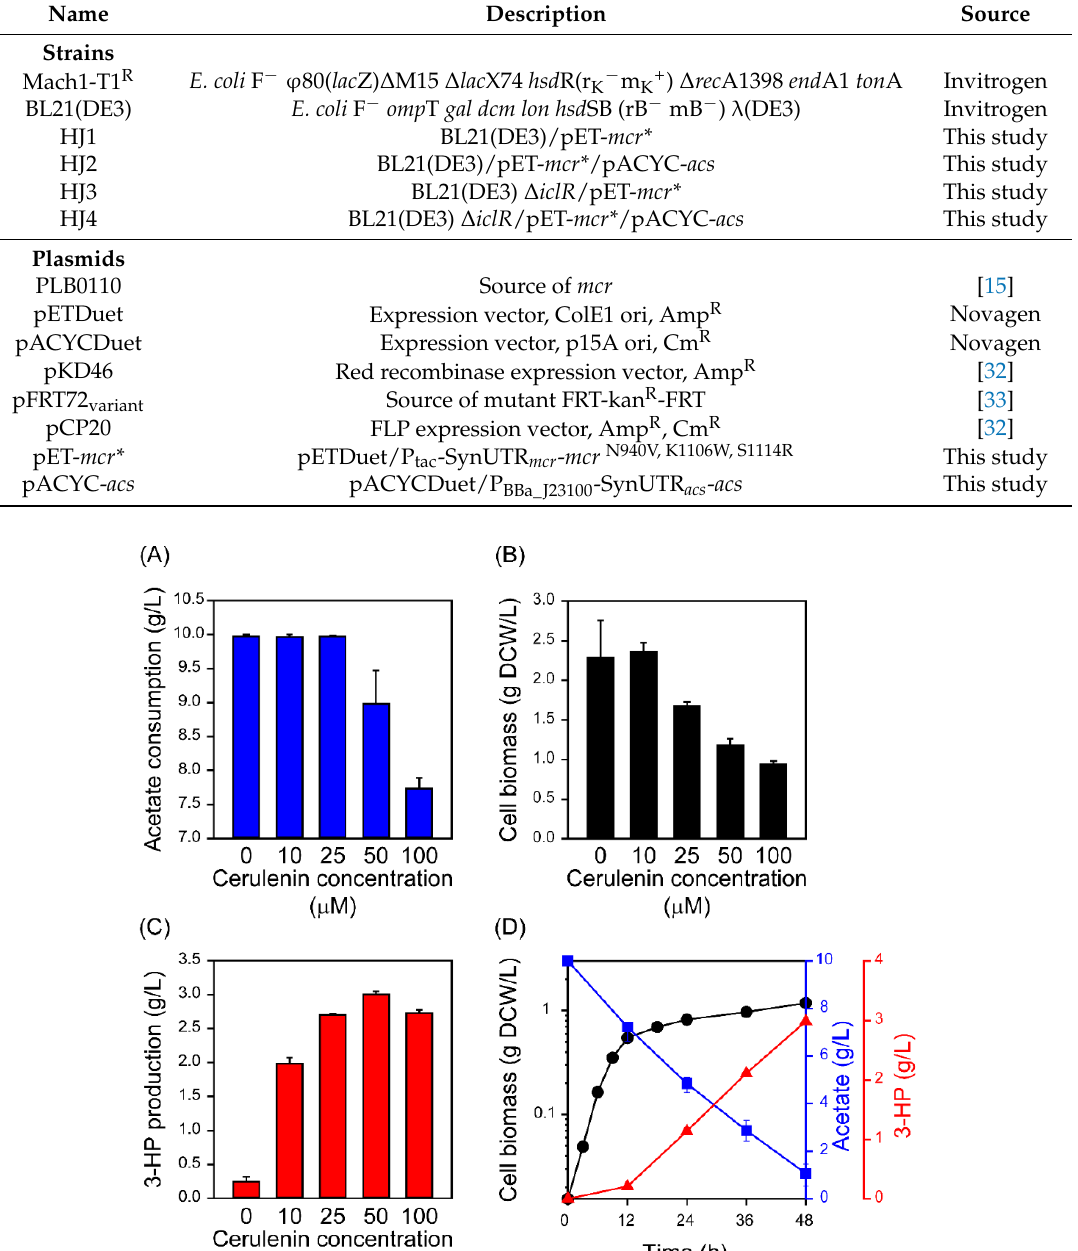
Table 2. Bacterial strains and plasmids used in this study.